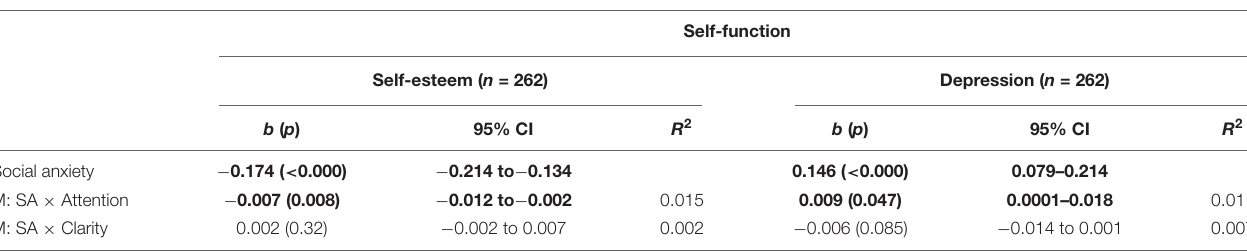
TABLE 3 | Social anxiety (conditional) effects and self-mentalizing moderation effects on